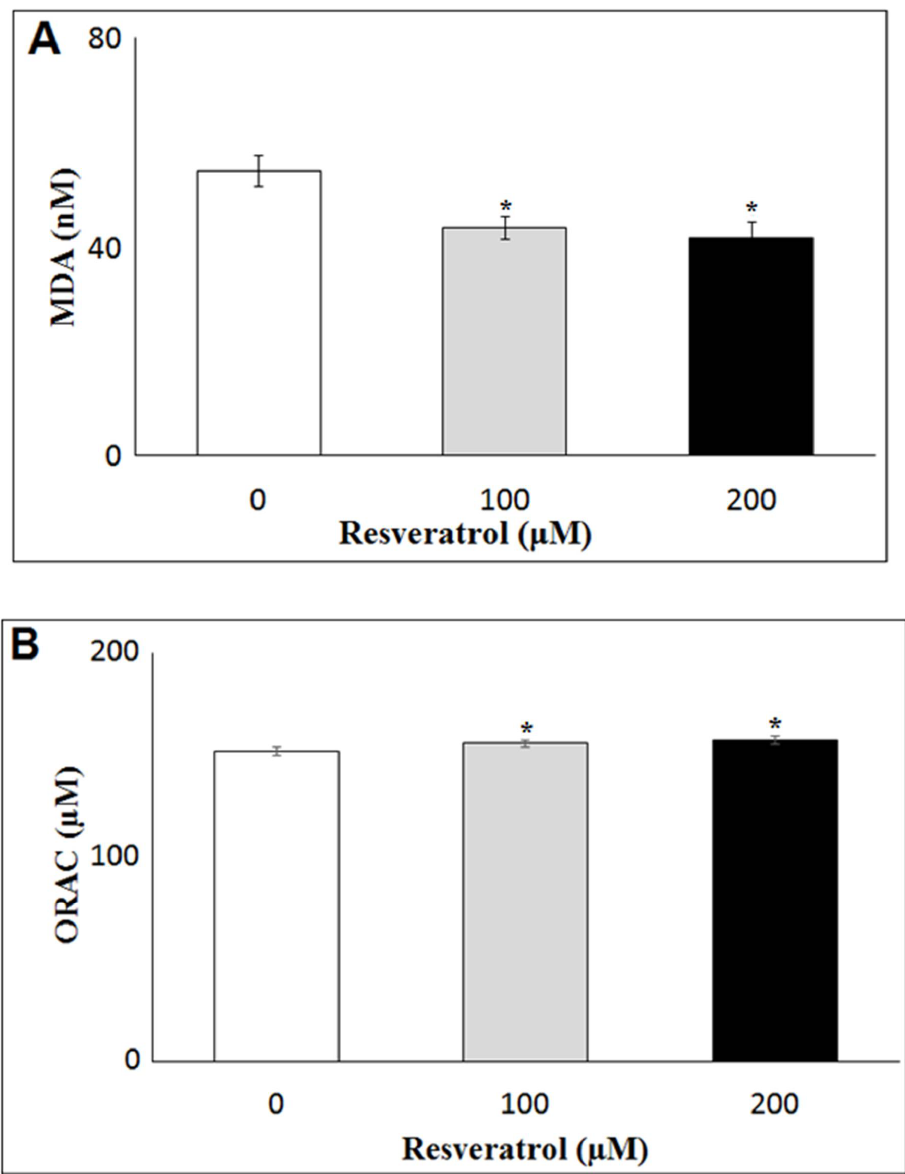
Figure 2. Indicators of oxidative stress in medium of DFAT cells treated with RSV at 100 and 200 µM by measuring ( A ) malondialdehyde (MDA) content and ( B ) oxygen radical absorbance capacity (ORAC) at 48 h. * indicates significant difference ( p < 0.05).